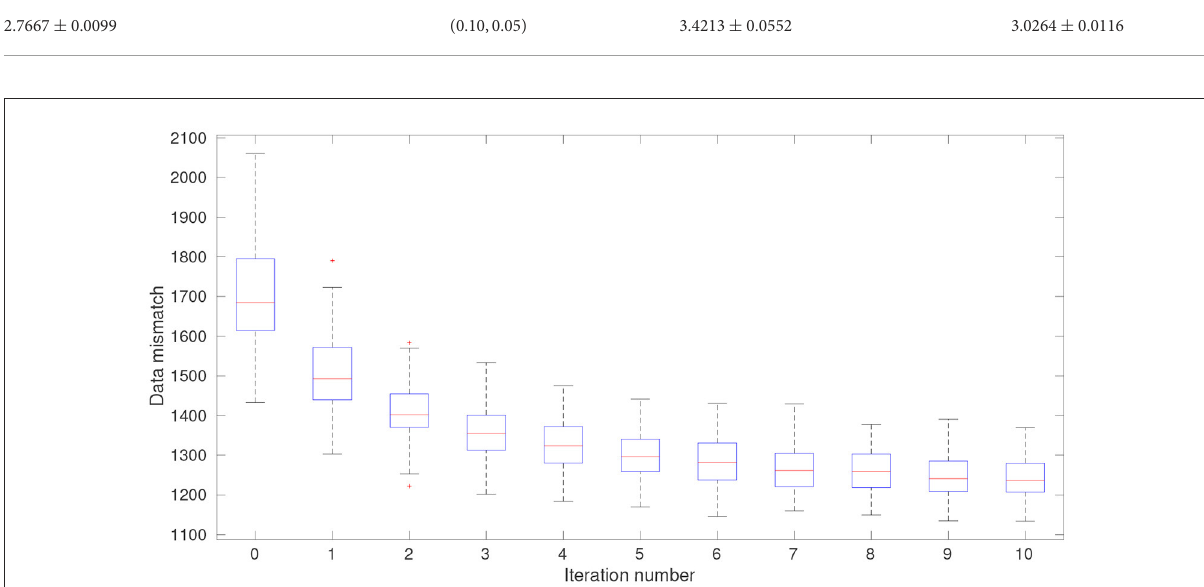
FIGURE5 Box plots of data mismatch at different iteration steps at one of the data assimilation cycles of the 1,000-dimensional L96 model.